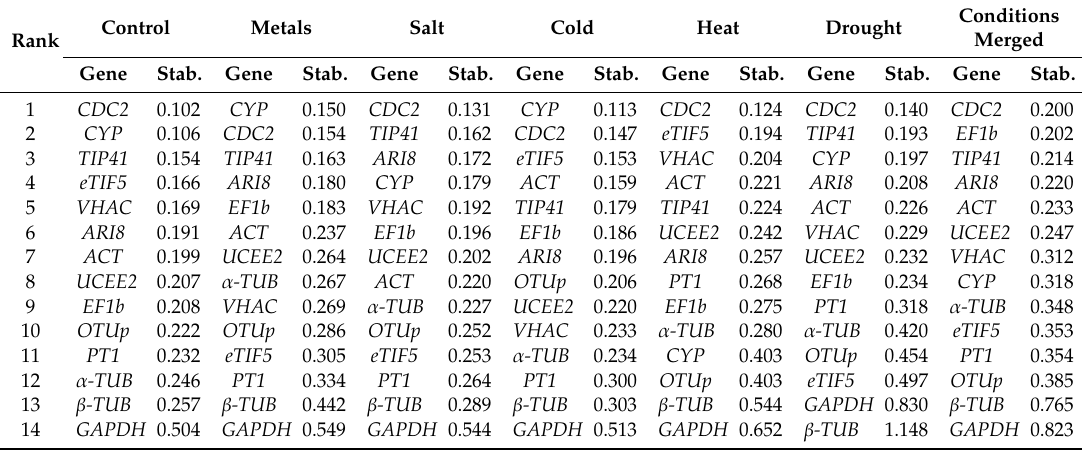
Table 5. Potential RGs to normalize qPCR data in Salix viminalis roots exposed to various abiotic stresses. Plants were exposed to the stresses for up to two months. Stability value of candidate RGs was determined by NormFinder. Genes are ranked from top to bottom in order of decreasing stability, lower values indicate higher stability. Stab.: gene stability value.